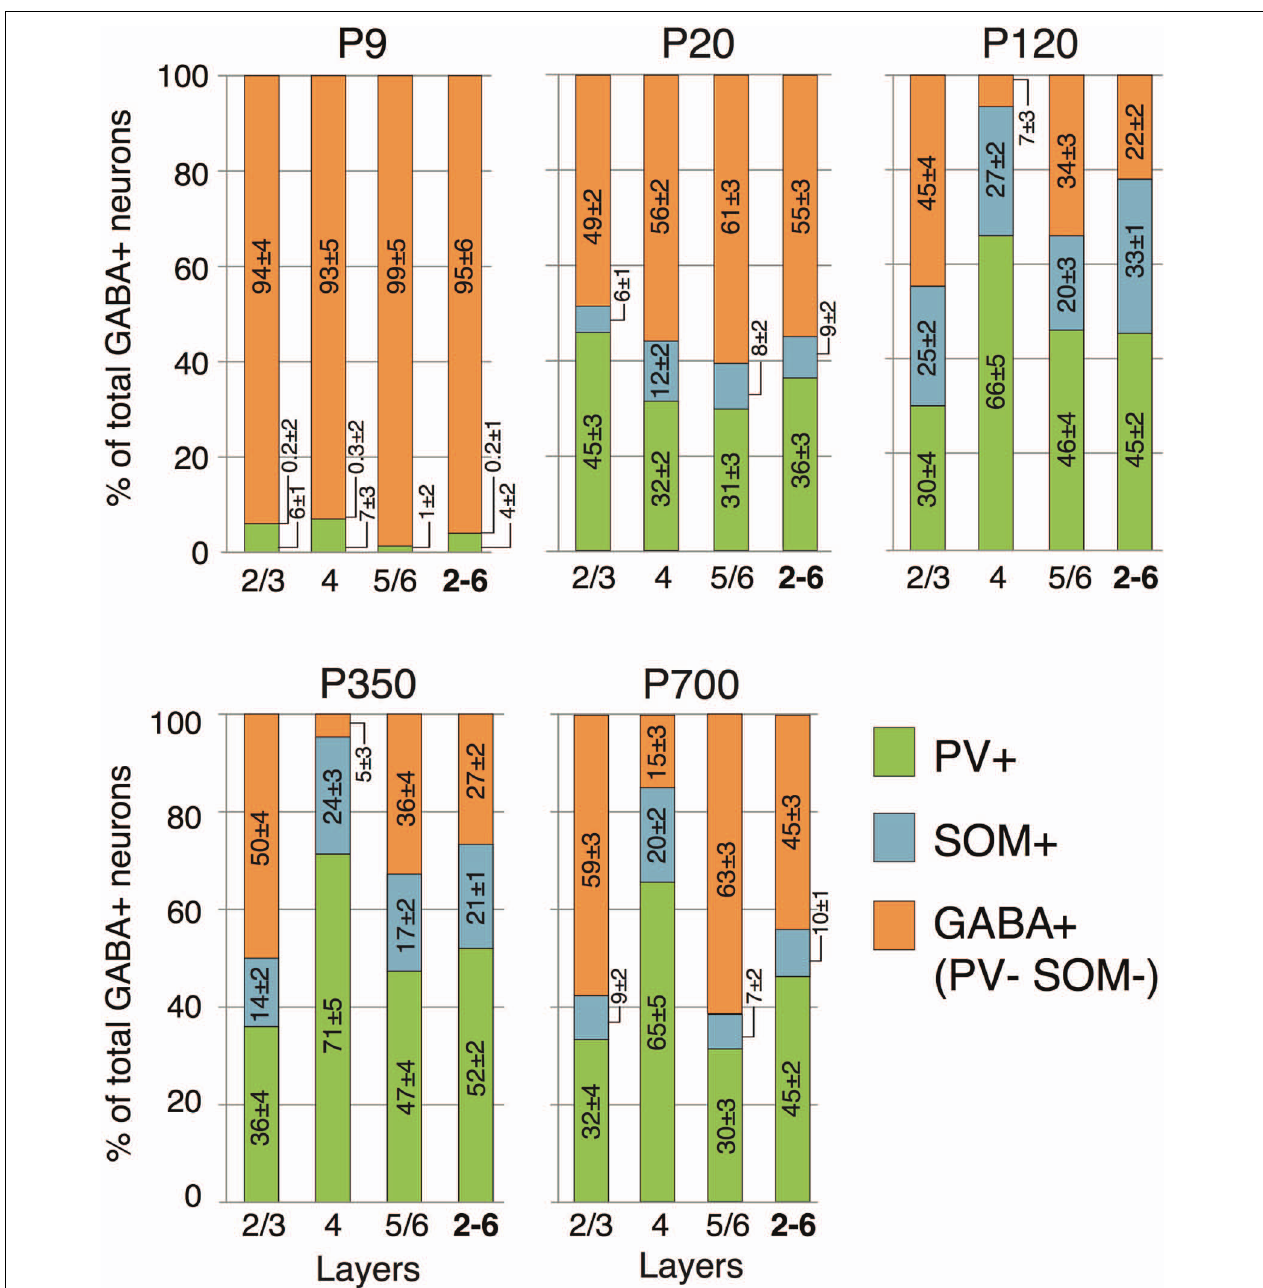
FIGURE 6 | Laminar distribution of PV and SOM neuron markers according to age. Numbers reported in the columns represent the percentage of cells immunostained relative to the total GABA + cells